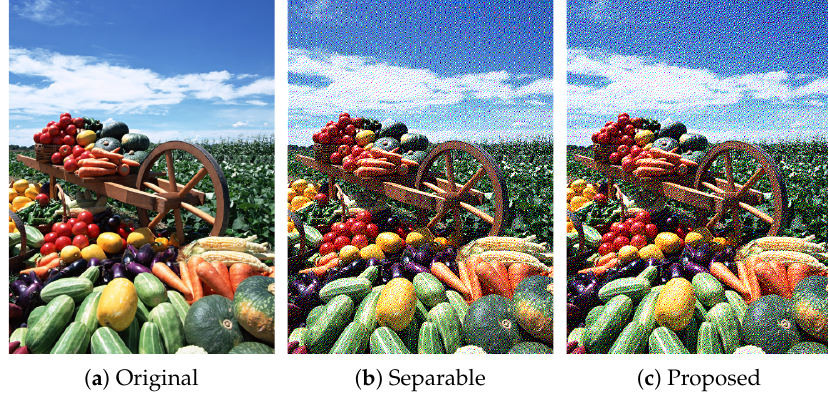
Figure 7. Color image